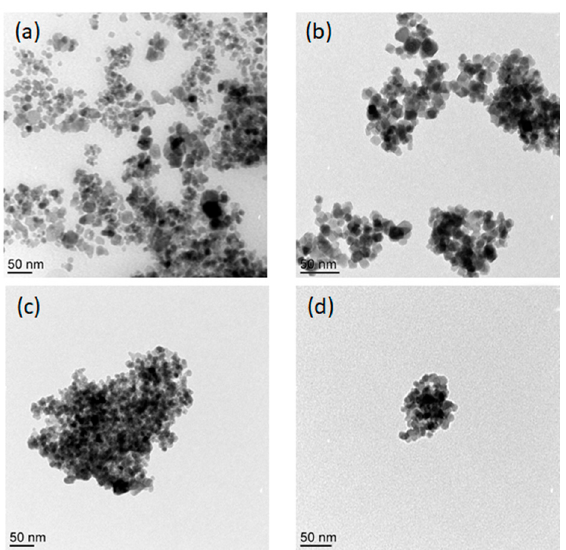
Figure 2. Transmission electron microscopy (TEM) images of coated and uncoated samples. ( a ) Sample 1, ( b ) Sample 2, ( c ) Sample 3, and ( d ) Sample 4.